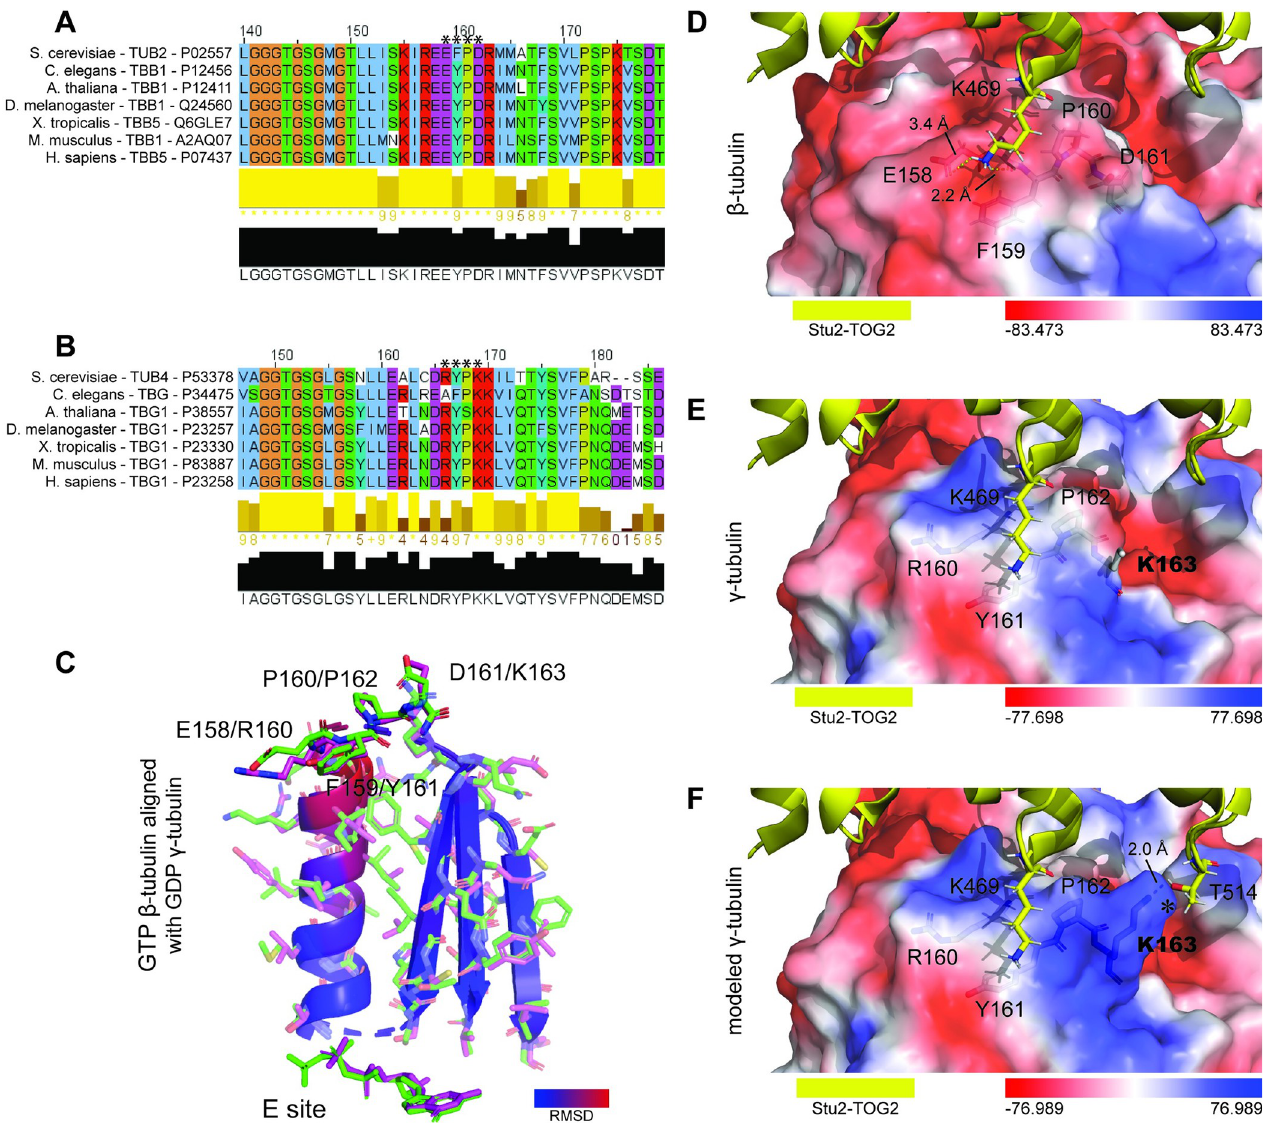
Fig 9. K469 is predicted to interact with the evolutionarily conserved EFPD and RYPK loops of β -and γ -tubulin. We evaluated evolutionary conservation of eukaryotic (A) β -tubulin EFPD and (B) γ -tubulin RYPK loops that are predicted to be responsible for tubulin interactions with Stu2 K469. (C) Structural alignments show similarities between GTP bound β -tubulin EFPD (pdb:4U3J) and GDP bound γ -tubulin RYPK (pdb:3CB2) loops. Electrostatic charge maps illustrate significant differences between the (D) electronegative β -tubulin EFPD loop (pdb:4U3J) and the (E) electropositive GCP2/Spc97 bound γ -tubulin RYPK loop in a closed confirmation γ -TuSC (pdb:5FLZ). To portray more accurately the positively charged surface of γ -TuSC embedded γ -tubulin, an electrostatic surface map (F) was generated following γ -tubulin K163 side chain reconstruction. The K163 sidechain of γ -tubulin is in position to form an additional salt bridge with T514 found in the Stu2 TOG2 domain (panel F marked with �